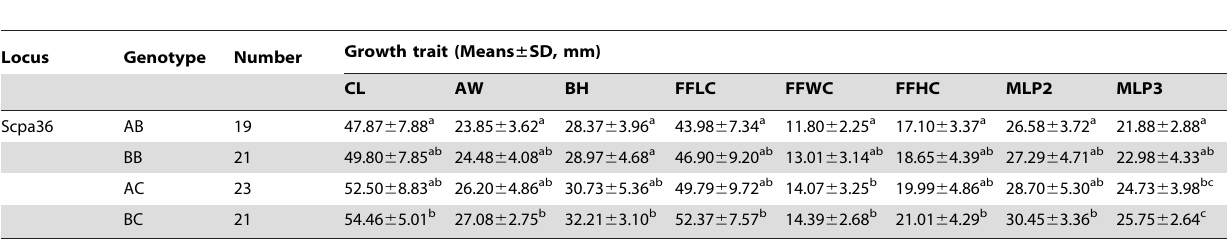
Table 2. Association analysis between microsatellite locus Scpa36 and eight growth traits of S. paramamosain.